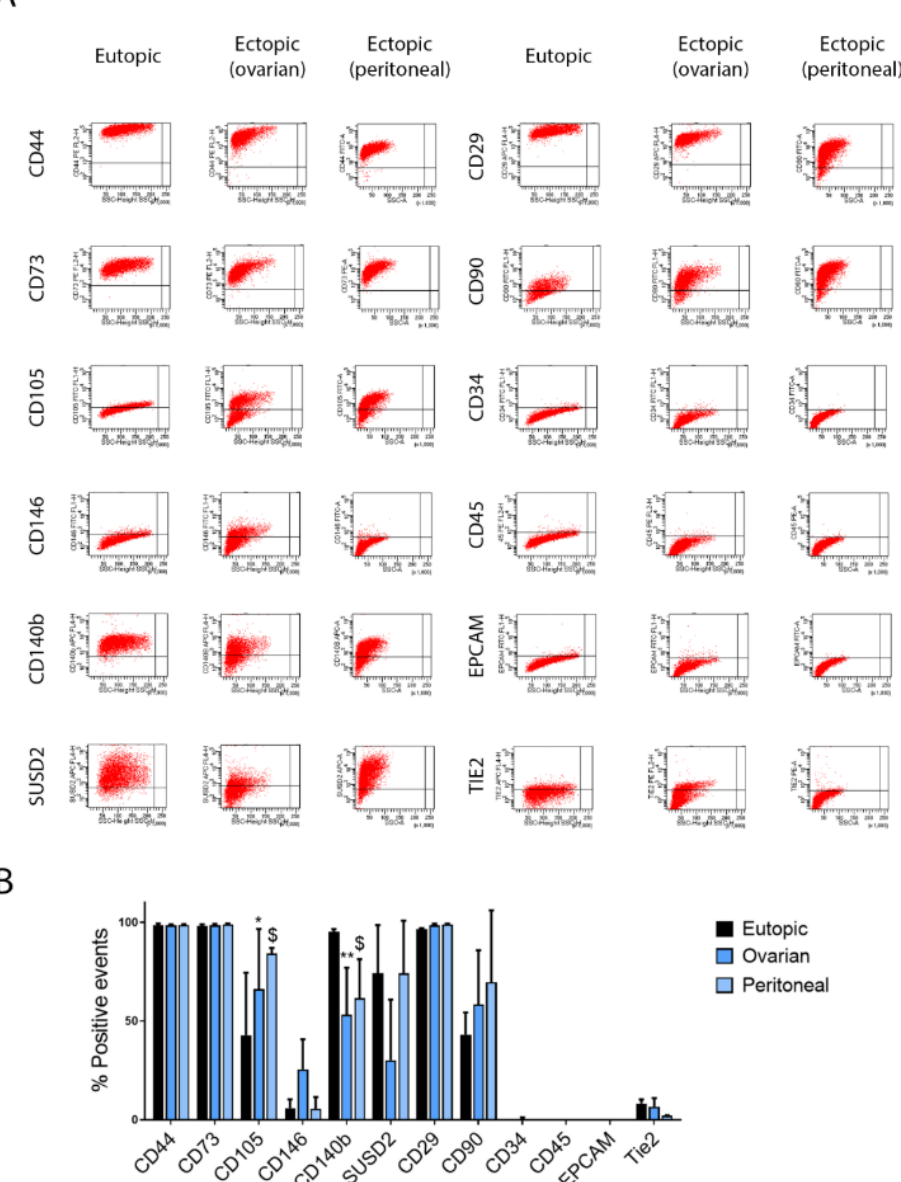
Figure 1. Expression of mesenchymal, hematopoietic, endometriotic, epithelial and endothelial markers by human eutopic and ectopic E-MSCs. Representative FACS analysis ( A ) and quantification ( B ) of eutopic and ectopic (both ovarian and peritoneal) E-MSCs lines for the expression of mesenchymal (CD44, CD73, CD90, CD29, CD105, CD146), hematopoietic (CD45, CD34), endometriotic (SUSD2, CD140b), epithelial (EPCAM) and endothelial (TIE2) markers. Analyses were performed on every cell line used in the study between passage 1 and 2. Data are shown as mean ± SD of all the tested lines: eutopic ( n = 3), ovarian ( n = 6) and peritoneal ( n = 3) ectopic E-MSCs. P: p -value; * = p < 0.05, ** = p < 0.01 (ovarian vs. eutopic); $ = p < 0.05 (peritoneal vs. eutopic).